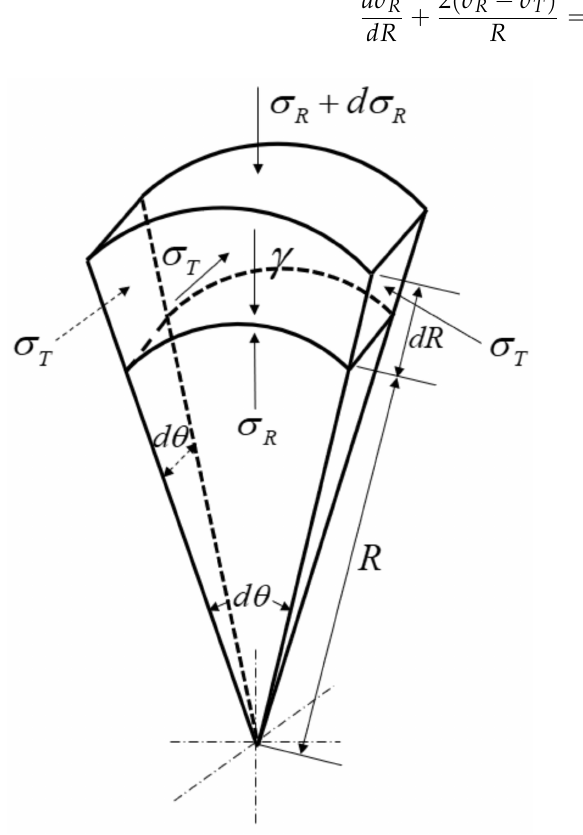
Figure 1. Detail of an element of the soil arch at the crown of the